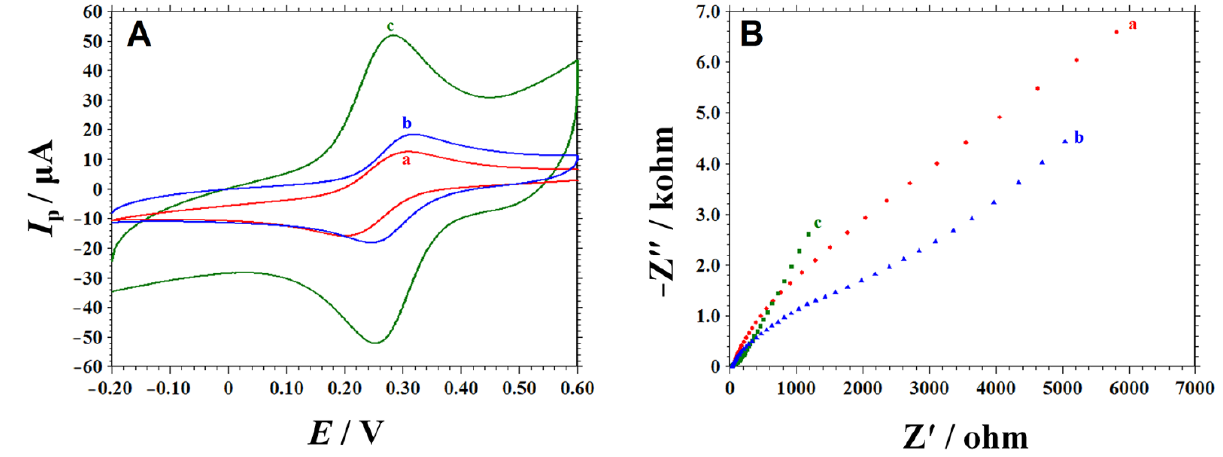
Figure 4. C.V.s ( A ) and EIS ( B ) of different electrodes: bare GCE (a), f-NC1/GCE (b) and f-NC2/GCE (c) in 1.0 mmol L − 1 K 3 Fe(C.N.) 6 solution with 1.0 mol L − 1 KCl as supporting electrolyte. The inset in Figure 4B represents the equivalent circuit models.